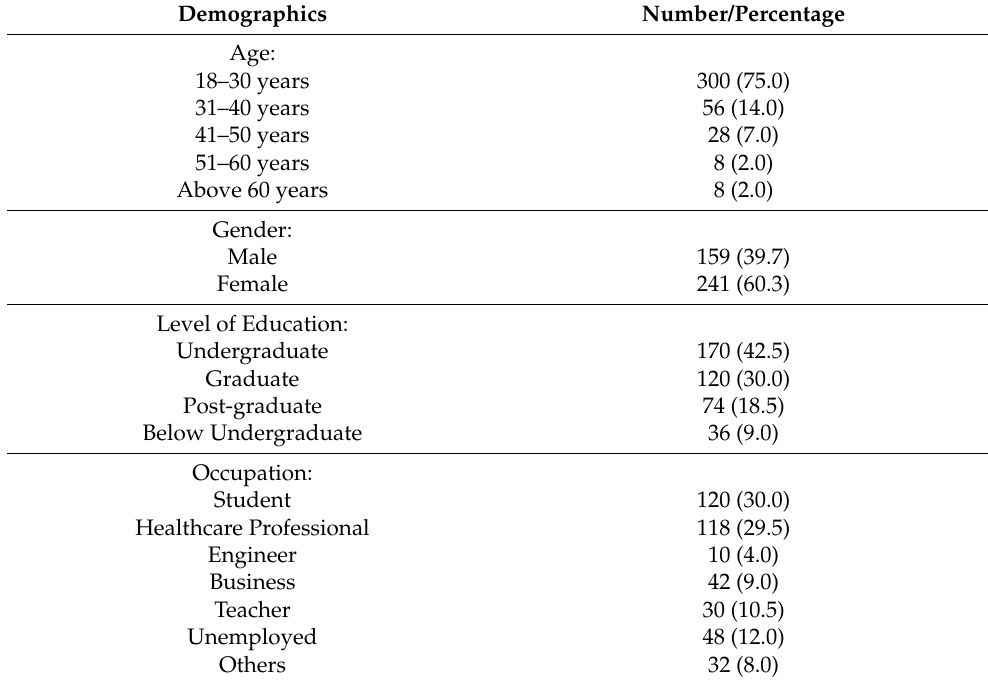
Table 1. Distribution of demographic details of participants ( n =